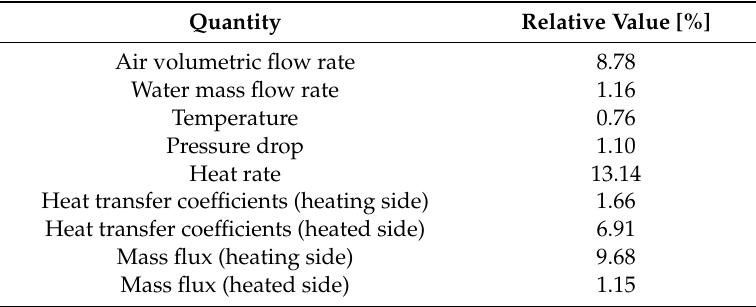
Table 3. Maximal uncertainties